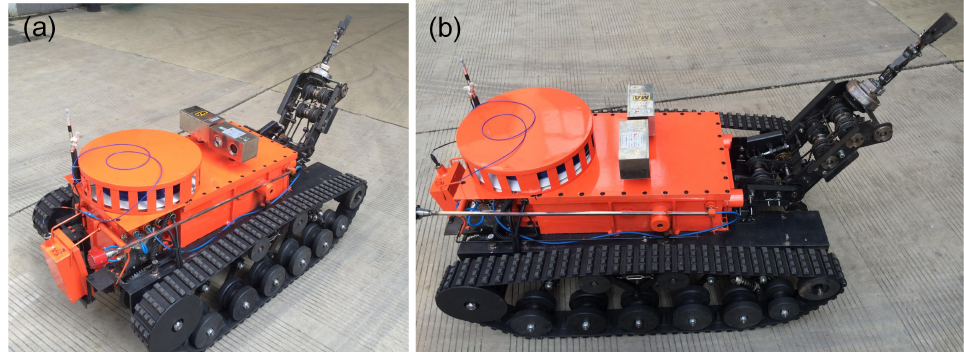
Figure 3. The coal mine search-and-rescue robot is shown in ( a , b